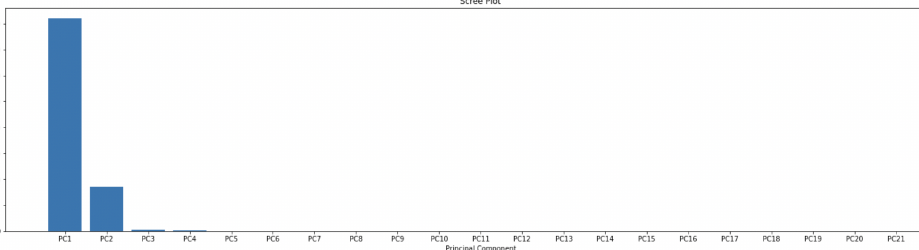
Figure 14. Scree plot of the gender voice recognition dataset.